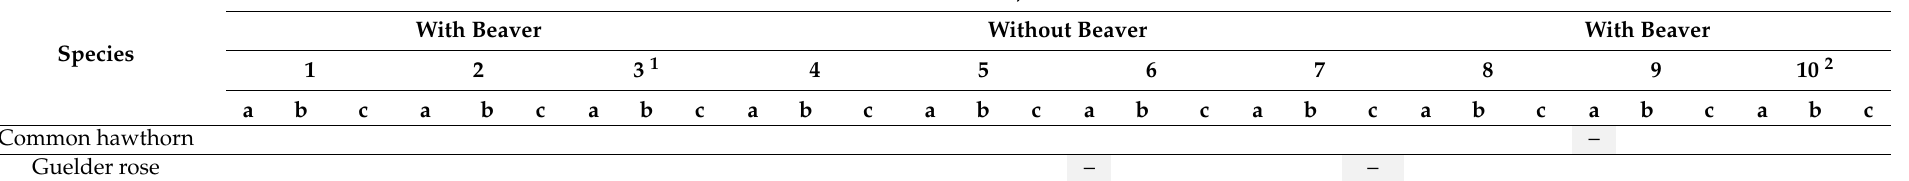
Beaver Presence/Absence, Plot Number and Distance Zone